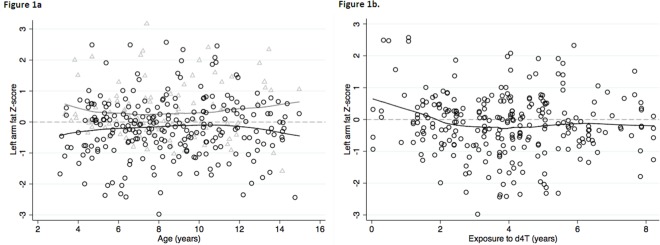
a. Left arm fat Z-scores of HIV-infected children over age.Black circles: scatterplot and locally weighted scatterplot smoothing line (LOWESS) of children exposed to stavudine; Grey triangles: scatterplot and LOWESS of children not exposed to stavudine. b. Left arm fat Z-scores of HIV-infected children over years of stavudine exposure. Black circles: scatterplot and locally weighted scatterplot smoothing line (LOWESS) of children exposed to stavudine.